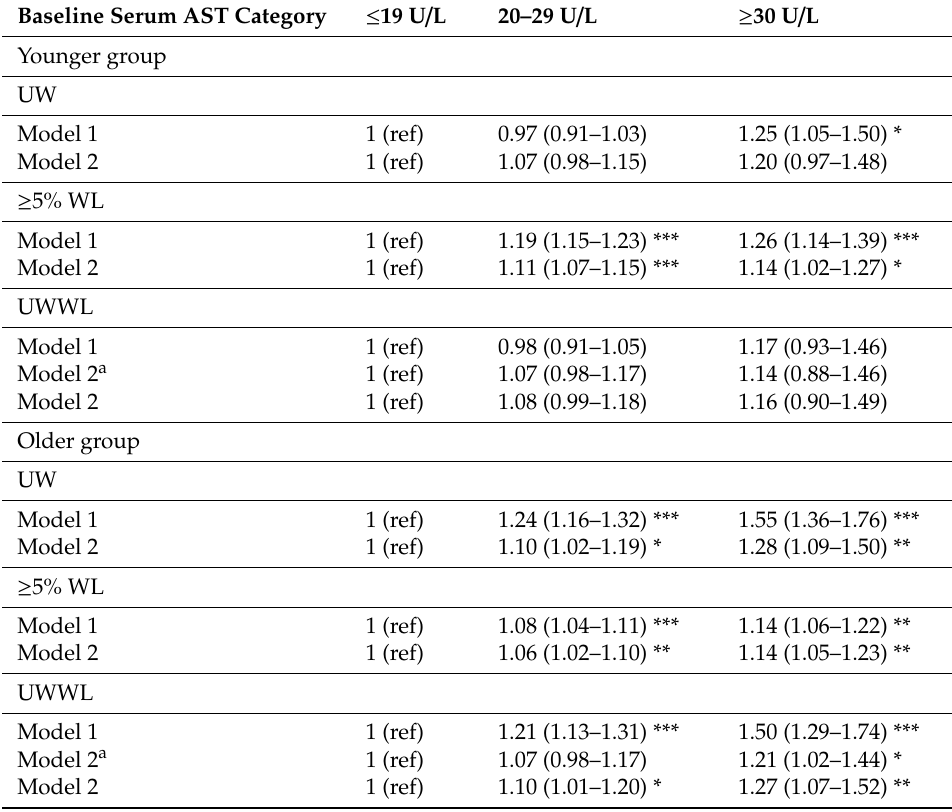
Table 4. Relative risk and 95% confidence intervals of associations between baseline serum aspartate aminotransferase and being underweight, ≥ 5% weight loss, and being underweight concomitant with weight